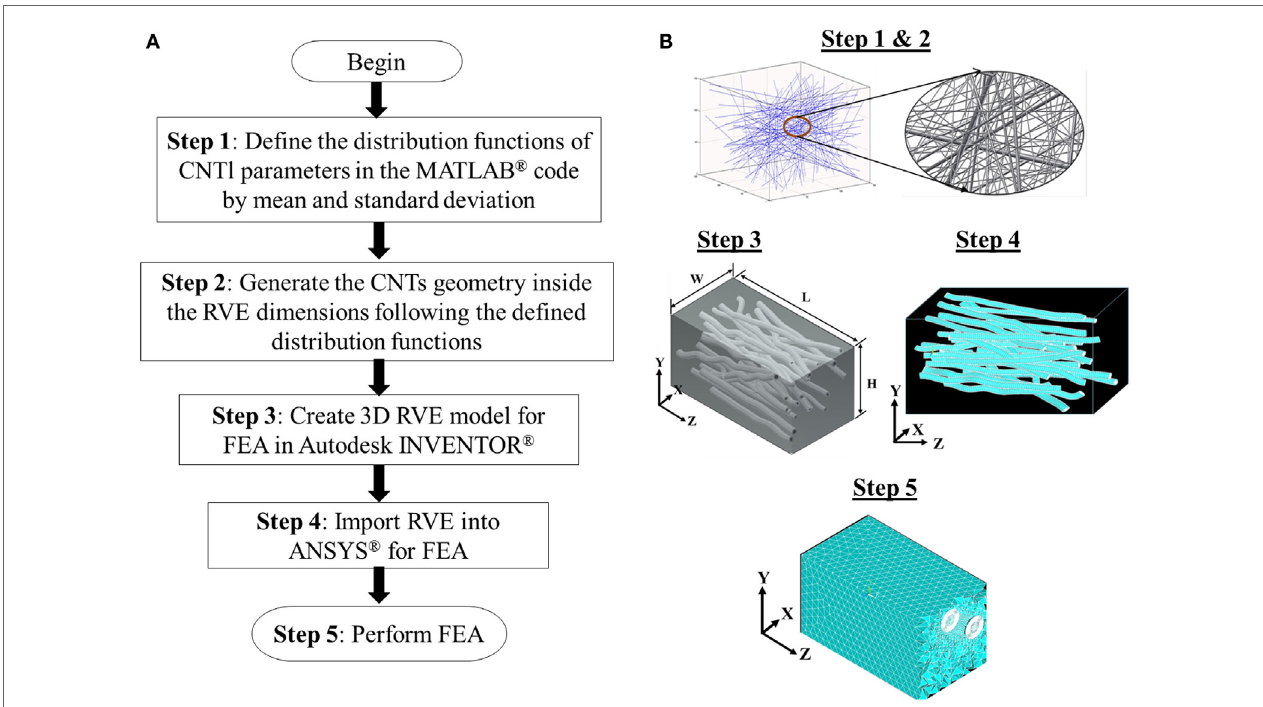
FigUre 3 | (a) Flow chart showing the steps used to generate RVE for the composites. (B) Schematic representation of the steps to generate 3D RVE of the composites for